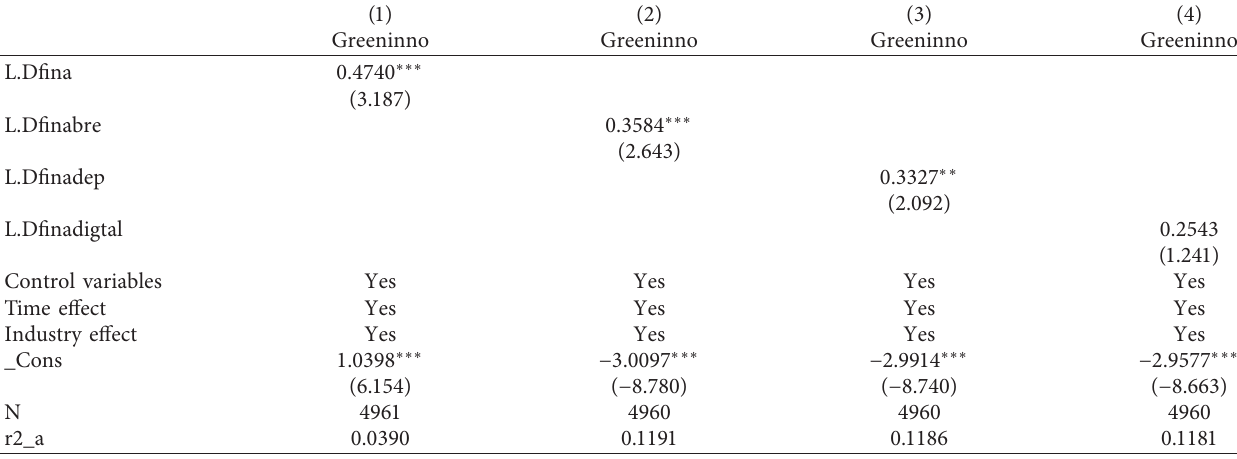
Table 2: The basic regression